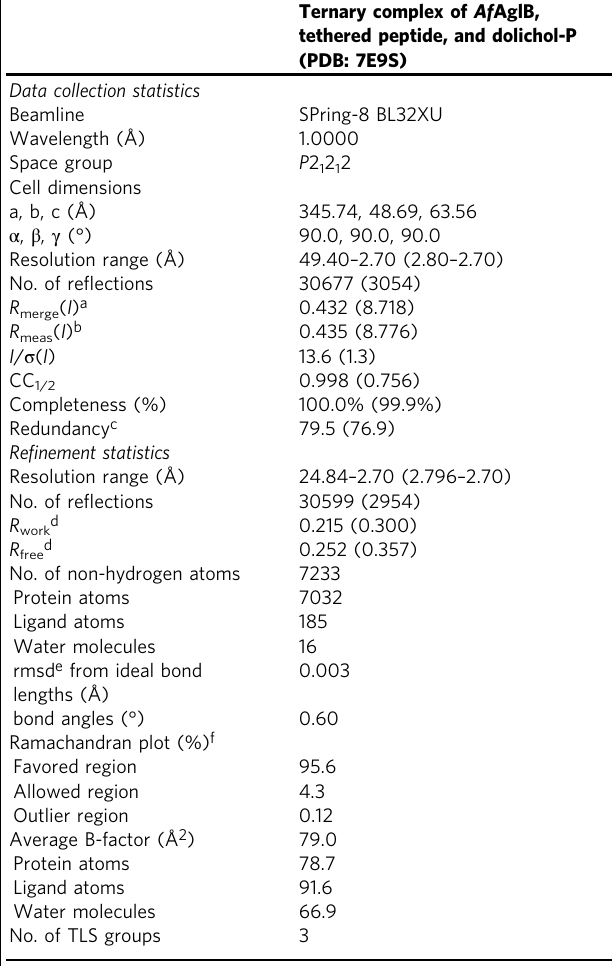
Table 1 Data collection and re fi nement